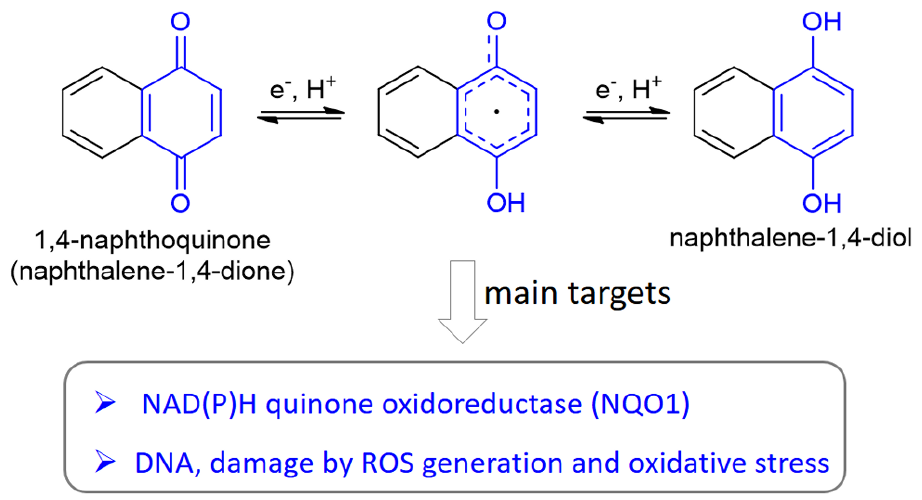
Figure 2. Redox reactivity of naphthoquinones, here shown for 1,4-NQ with the benzoquinone and hydroquinone units depicted in blue, and the main biological targets involved in this chemical re- activity.